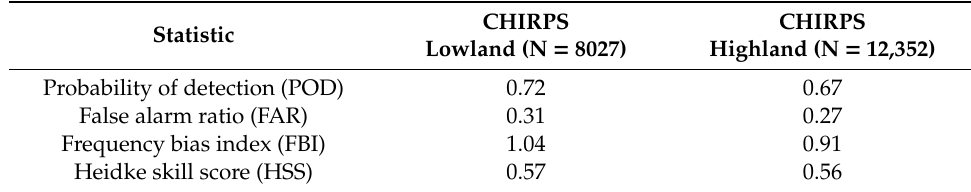
Table 4. Detection skill scores of daily rainfall (threshold > 1 mm) of CHIRPS SREs for Beles Basin, Lowland and Highland stations during 2005–2015 (N is the number of data pairs